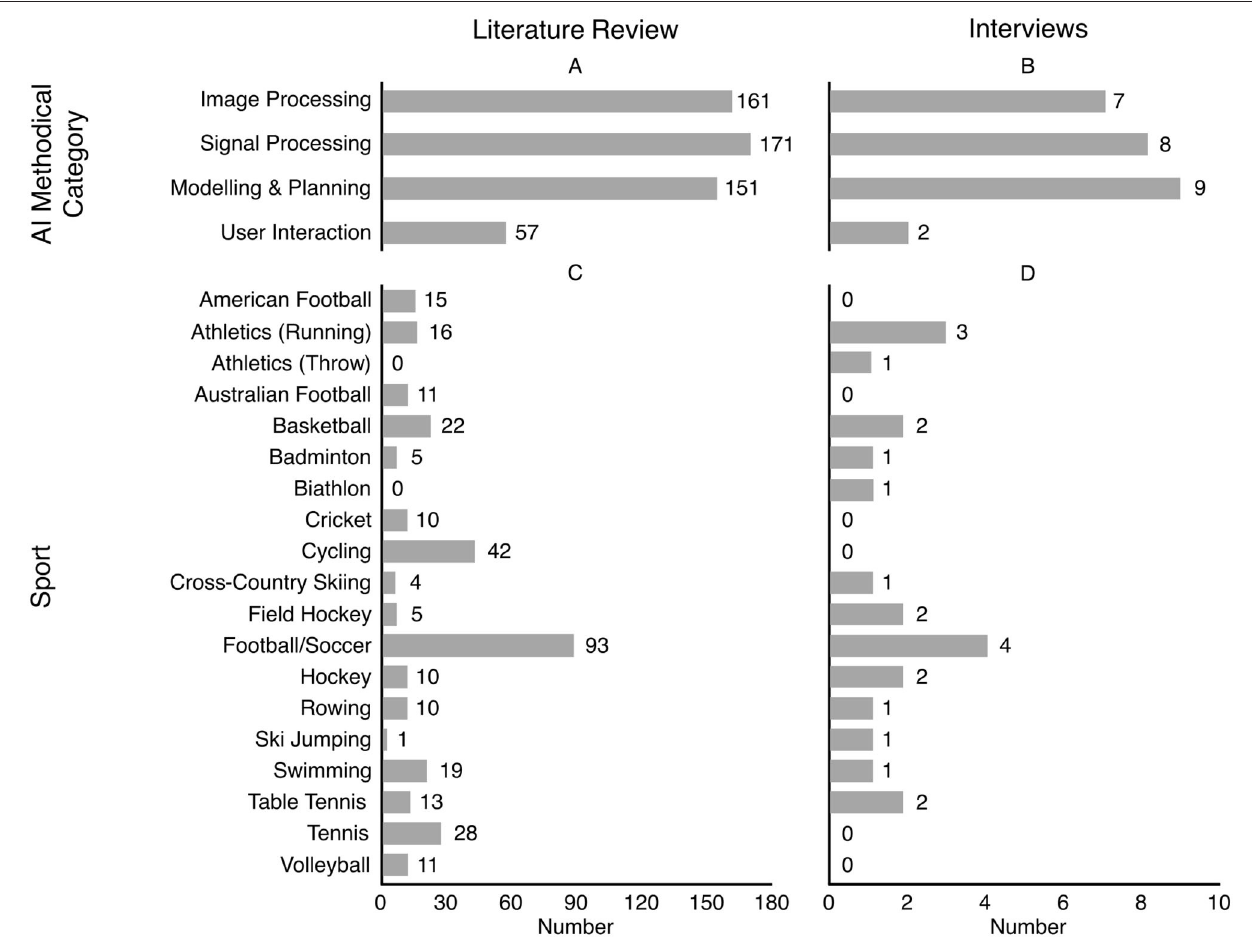
FIGURE 2 | Number of found publications regarding (A) the methodical category, (C) specific sports; mentioned projects by the interviewees regarding (B) the methodical category, (D) specific